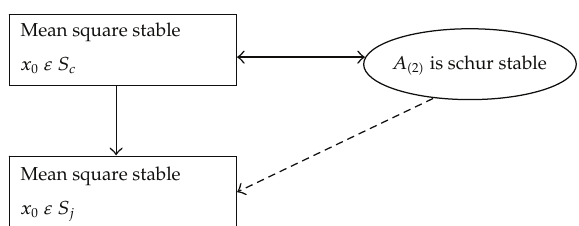
Figure 1: Relationship between di ff erent senses of mean square